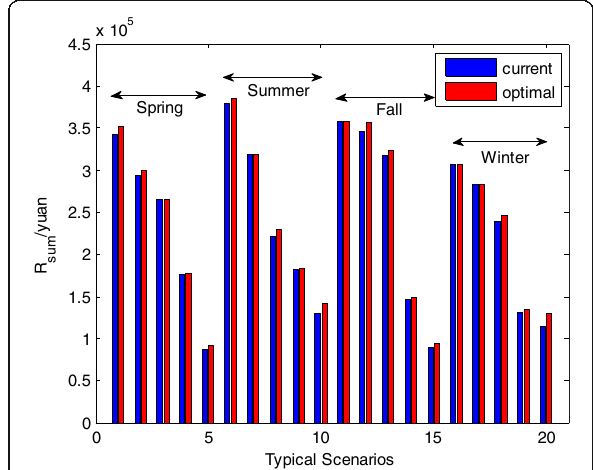
Fig. 11 Revenue comparison between the optimal typical scenario operation modes and the current operation